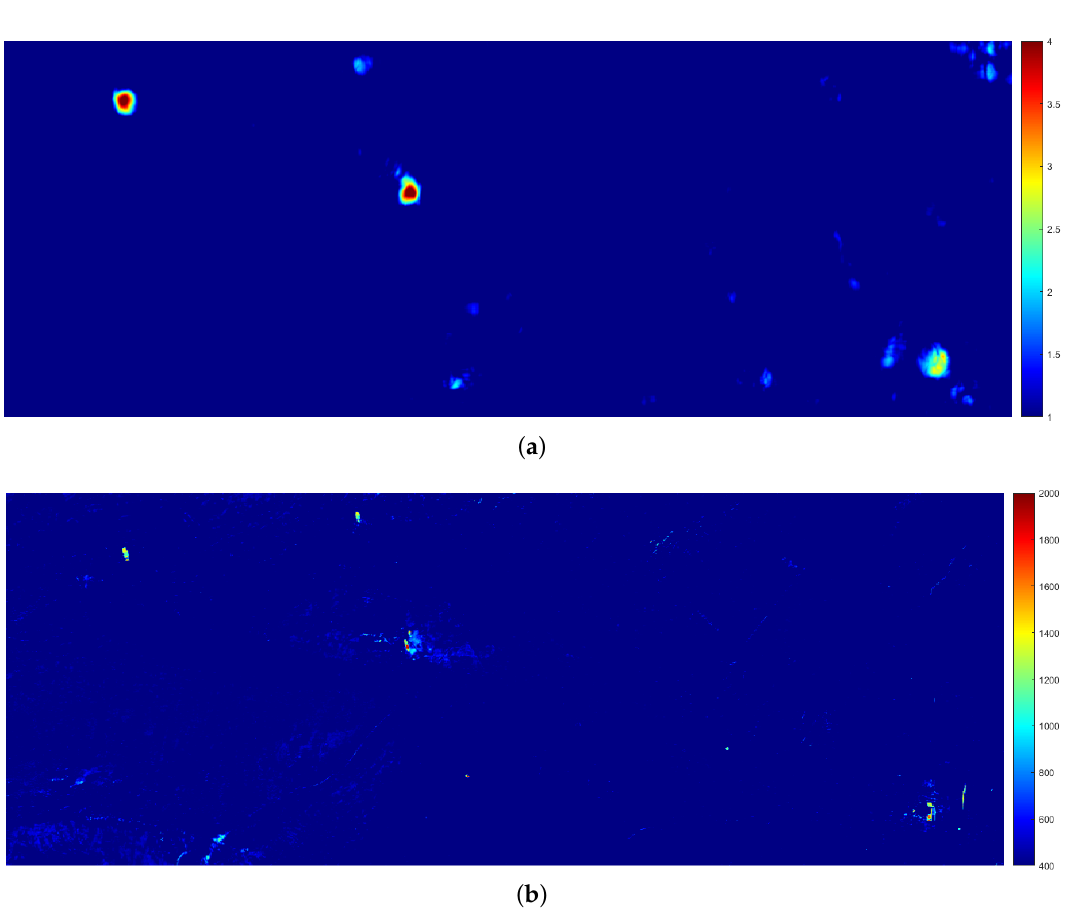
Figure 6. Preliminary change maps derived from differences of Gabor features ( a ) and Robust Differences ( b ). A limited number of false alarms is visible in both.